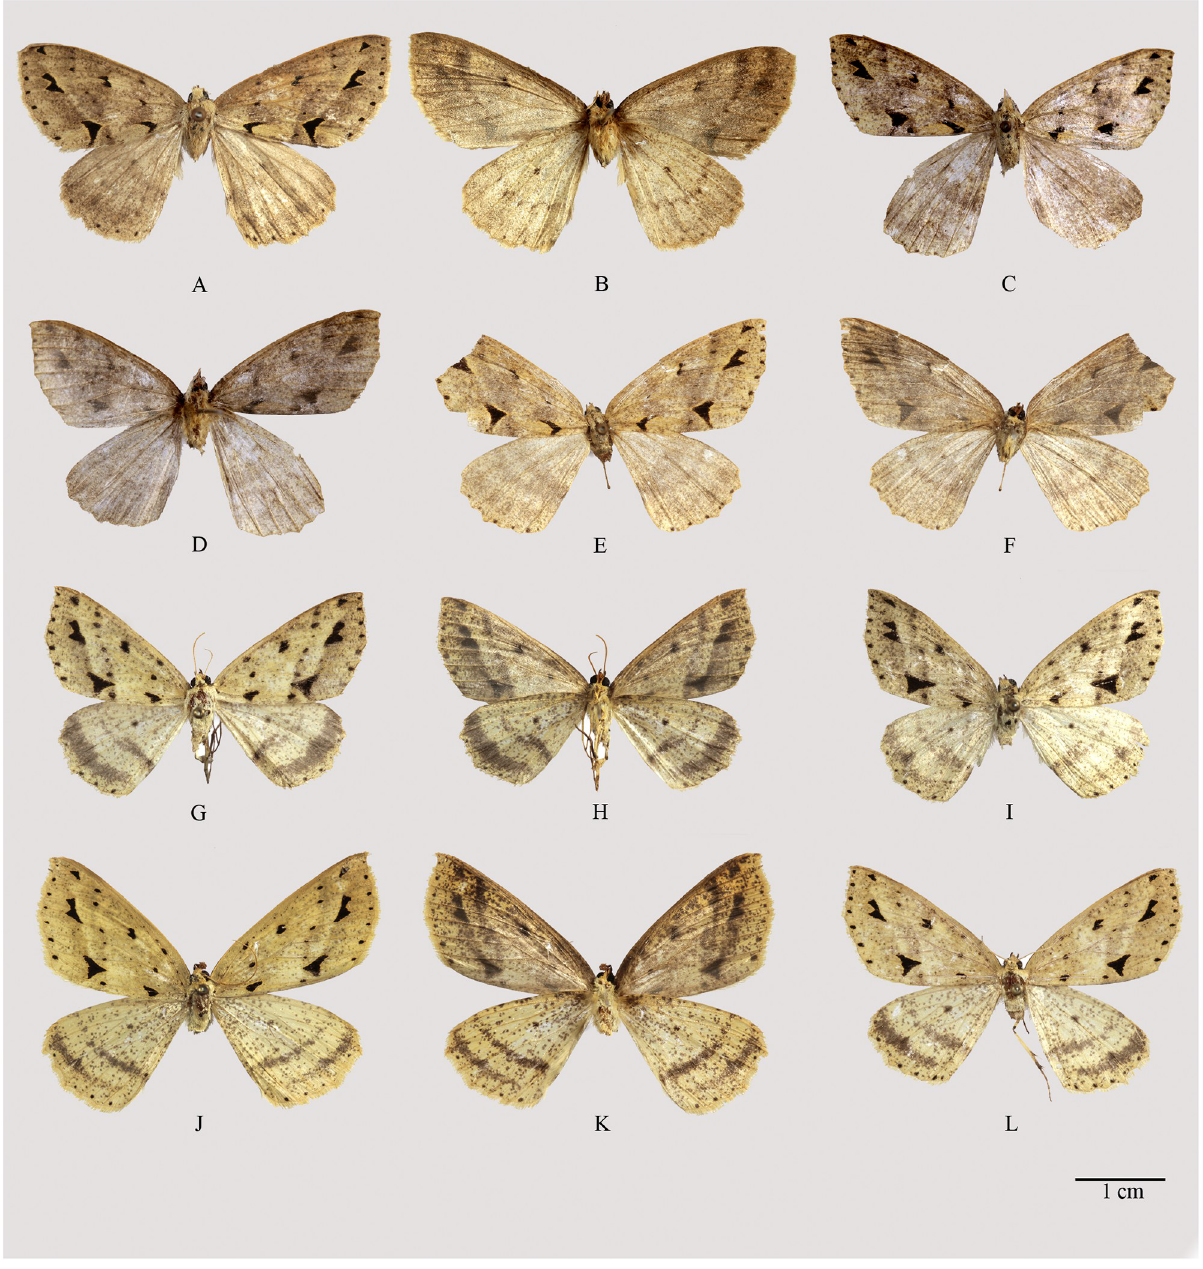
Fig 8. Habitus of Psyra szetschwana , P . fulvaria , P . dsagara , P . similaria . A. P . szetschwana ♂ B. P . szetschwana ♂ underside C. P . fulvaria ♂ D. P . fulvaria ♂ underside E. P . dsagara ♀ F. P . dsagara ♀ underside G. P . similaria ♂ H. P . similaria ♂ underside I. P . similaria ♂ (variation from Dihang Dibang Biosphere Reserve) J. P . similaria ♀ K. P . similaria ♀ underside L. P . similaria ♀ (pale morph).